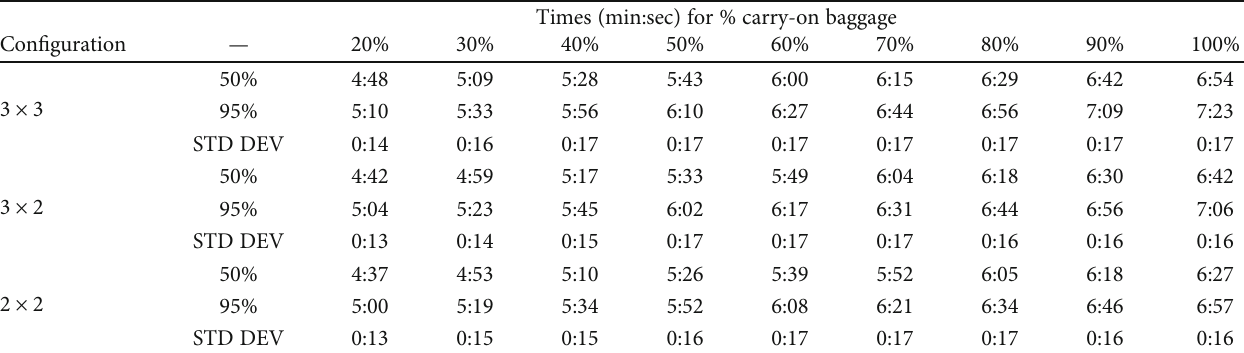
Table 10: Complete comparison of boarding times for the three aircraft con fi gurations using the random outside-in boarding strategy for di ff erent % of carry-on